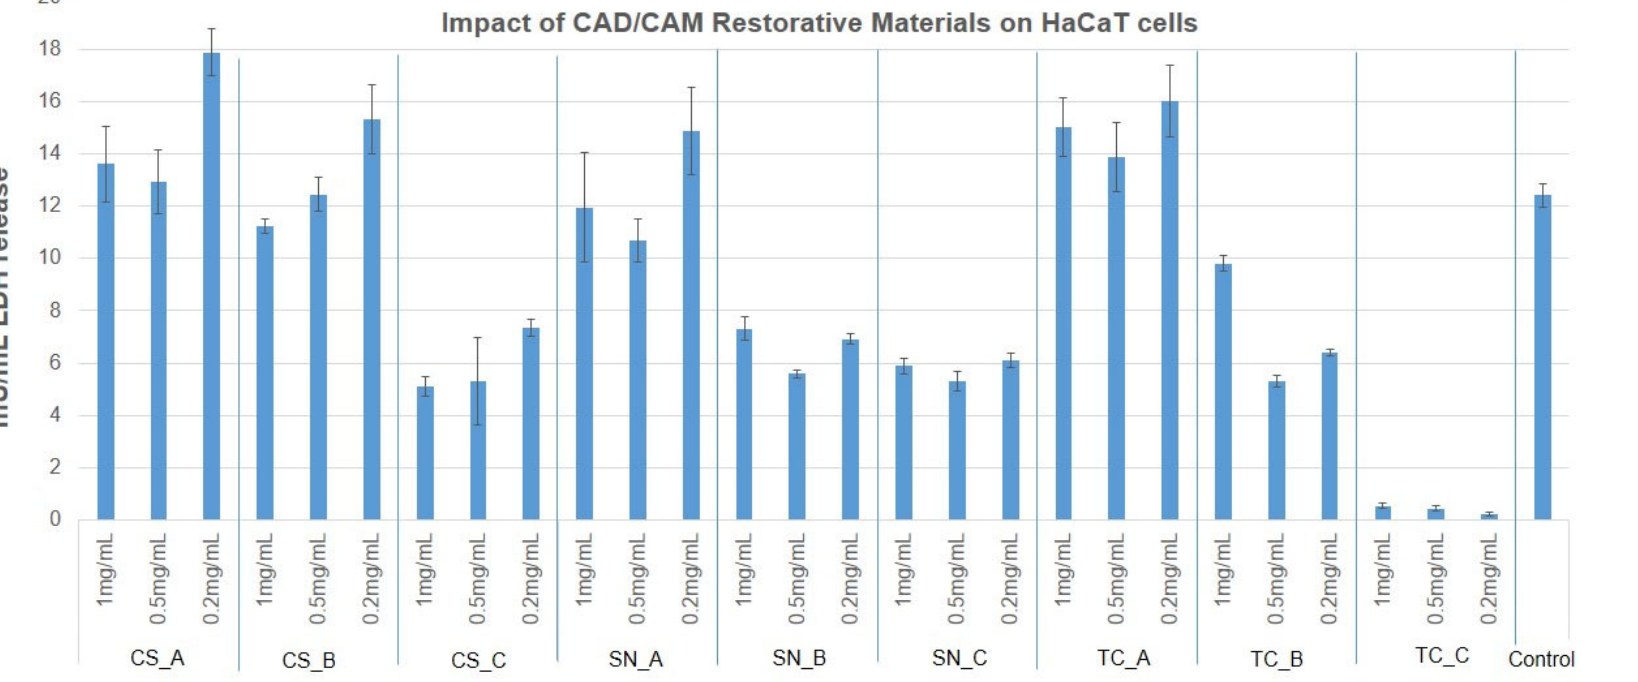
Figure 9. Cytotoxicity percentage of HaCaT cells, after treatment with nonexposed/exposed to acidic artificial saliva of CAD/CAM restorative materials powders, at three different concentrations (1 mg/mL, 0.5 mg/mL, and 0.2 mg/mL), for an interval of 24 h.